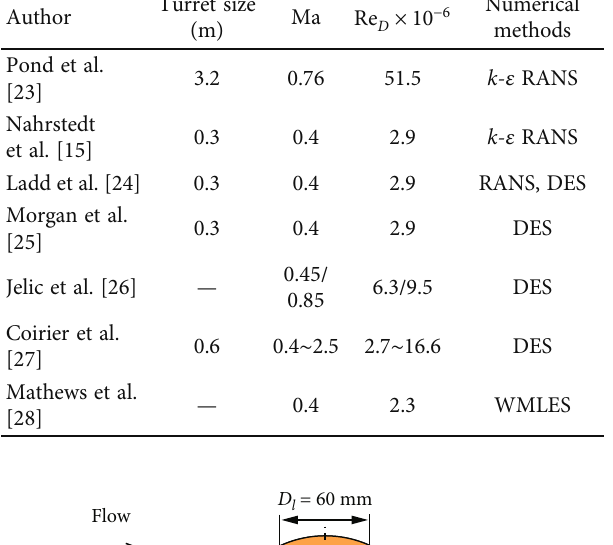
Table 1: Some numerical simulations for fl ow over laser turrets.